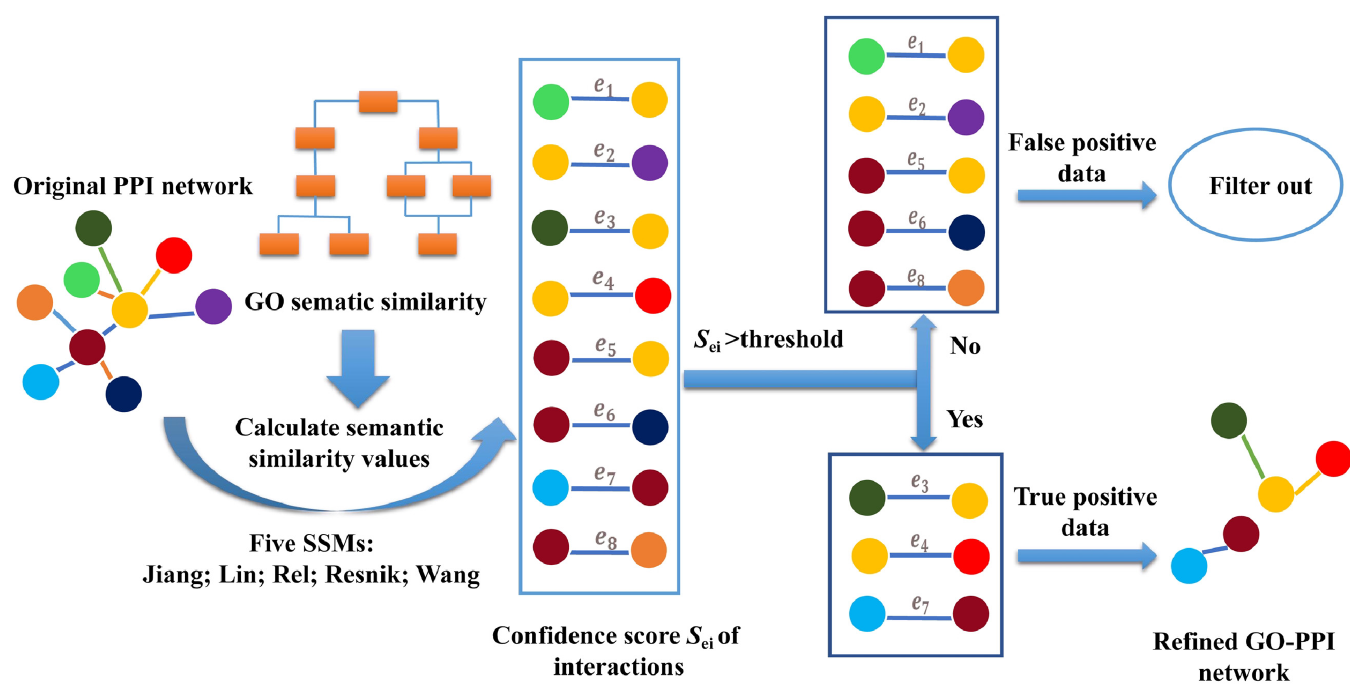
Fig 1. The process of constructing a GO-PPI network.